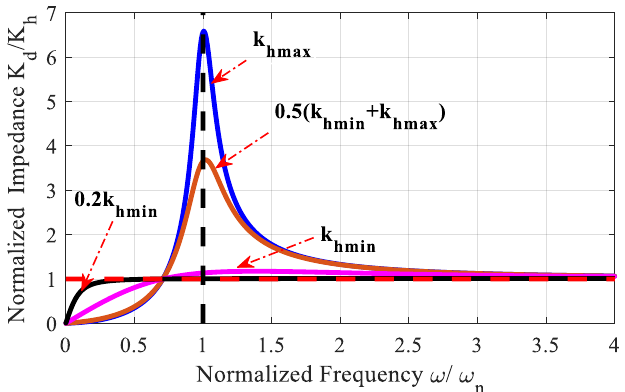
Figure 11. EHA stiffness without control input. Figure 11. EHA sti ff ness without control